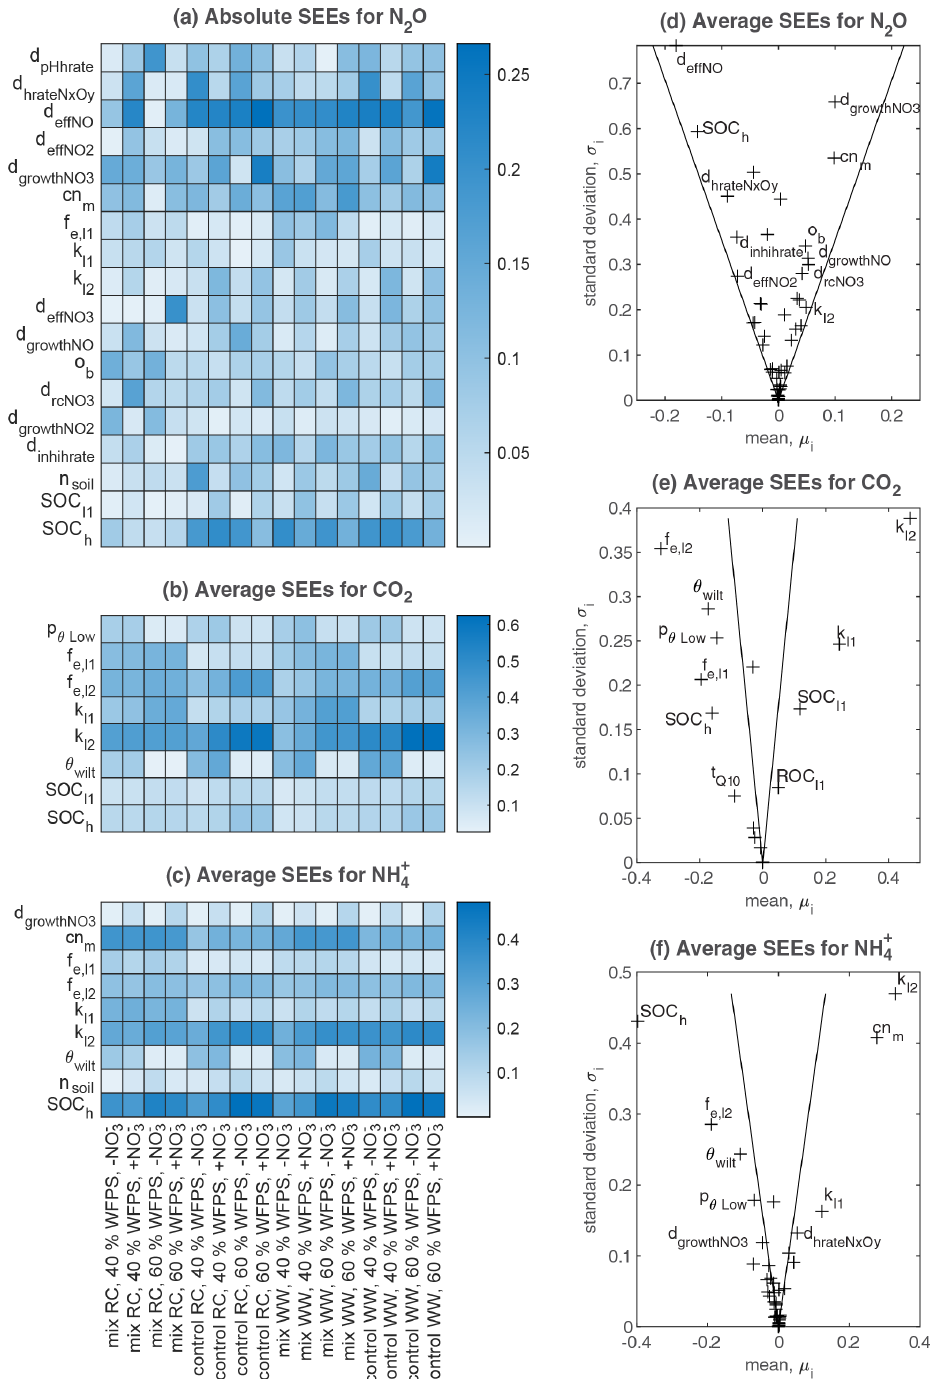
Figure 3. Sensitivity analyses for N 2 O flux, CO 2 flux, and soil NH + content in all treatments. (a–c) Heat maps that include all parameters 4 ranked in the top five places for each treatment based on absolute values of standardized elementary effects (SEEs) – the higher the absolute value, the more important the parameter is, as shown by the shade of color. (d–f) Estimated mean and standard deviation of SEEs averaged across the 16 treatments, where the two lines drawn in each subplot correspond to twice the standard error (sem): µ i = ± 2sem i (see Sect. 2.3.1): if a factor is located inside the wedge, its impact on the output is considered insignificant, and vice